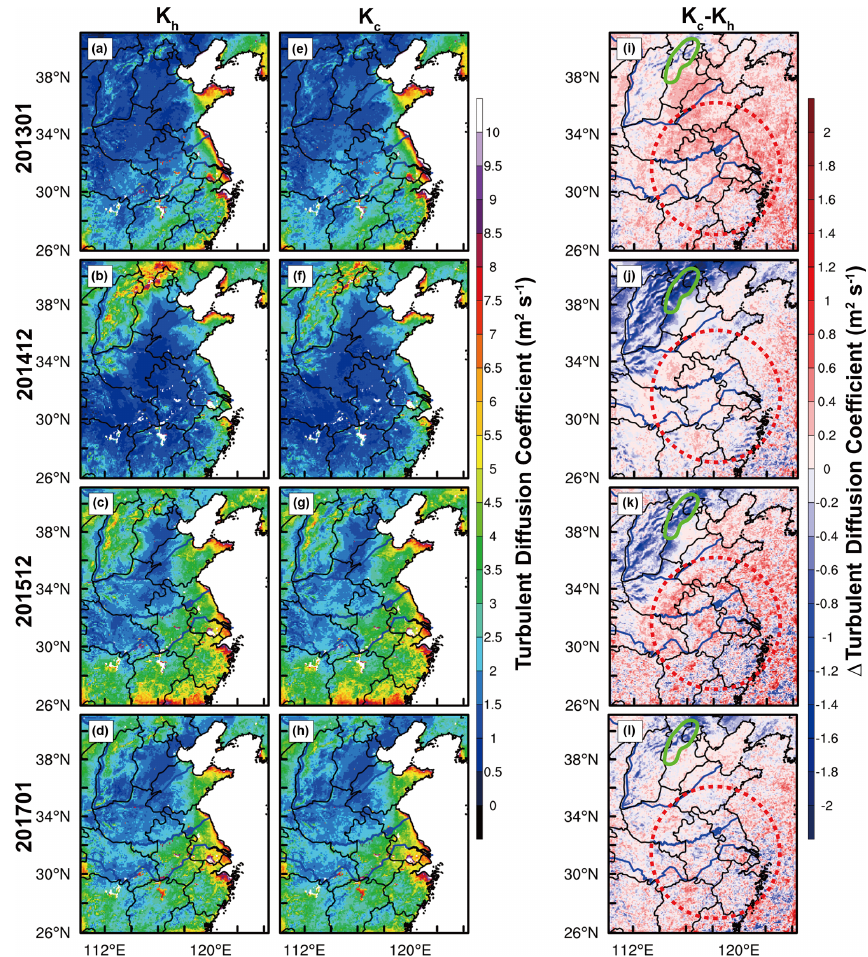
Figure 9. Turbulent diffusion coefficient of (a–d) heat and (e–h) particles and (i–l) the difference between two turbulent diffusion coefficients. The dashed red and solid green irregular circles represent eastern China and mountainous areas,